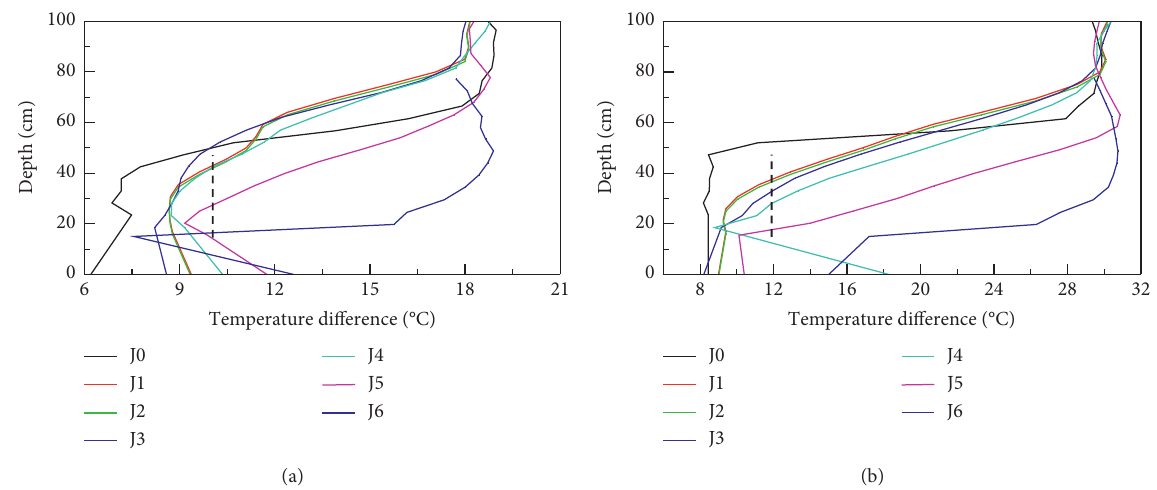
Figure 9: Distribution of temperature difference along height in different positions: (a) 10A; (b)